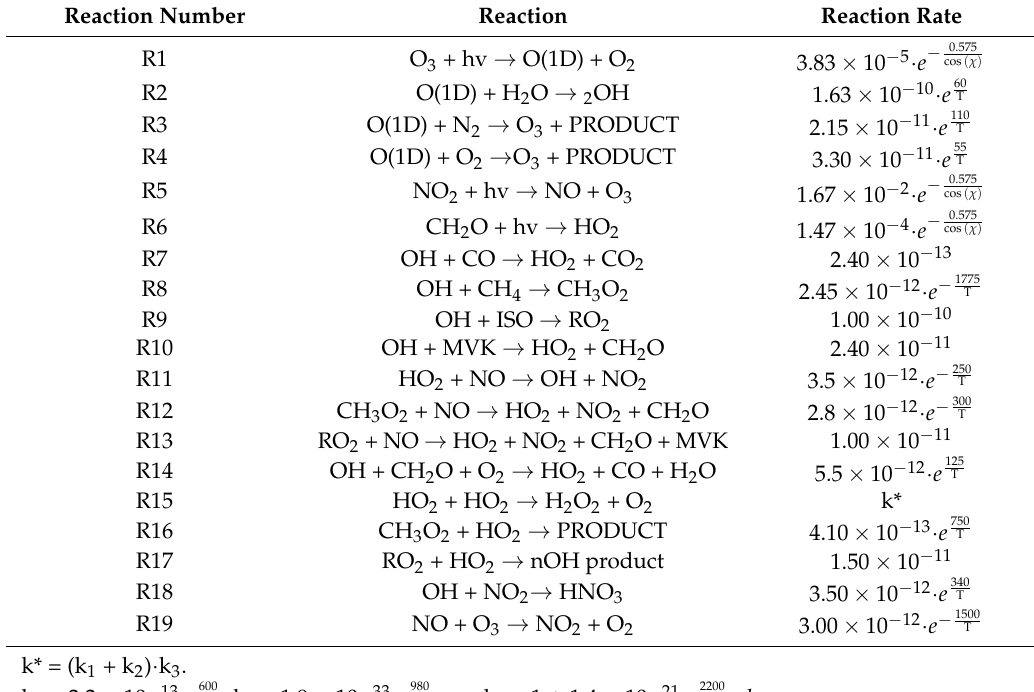
Table 2. Chemical reaction scheme solved in the numerical experiments by the chemical module of Dutch atmospheric large-eddy simulation (DALES). T is the absolute temperature in K. The product represents the species in the ambient air that were not directly evaluated. The photochemical reactions are marked with hv. MVK represents methyl vinyl